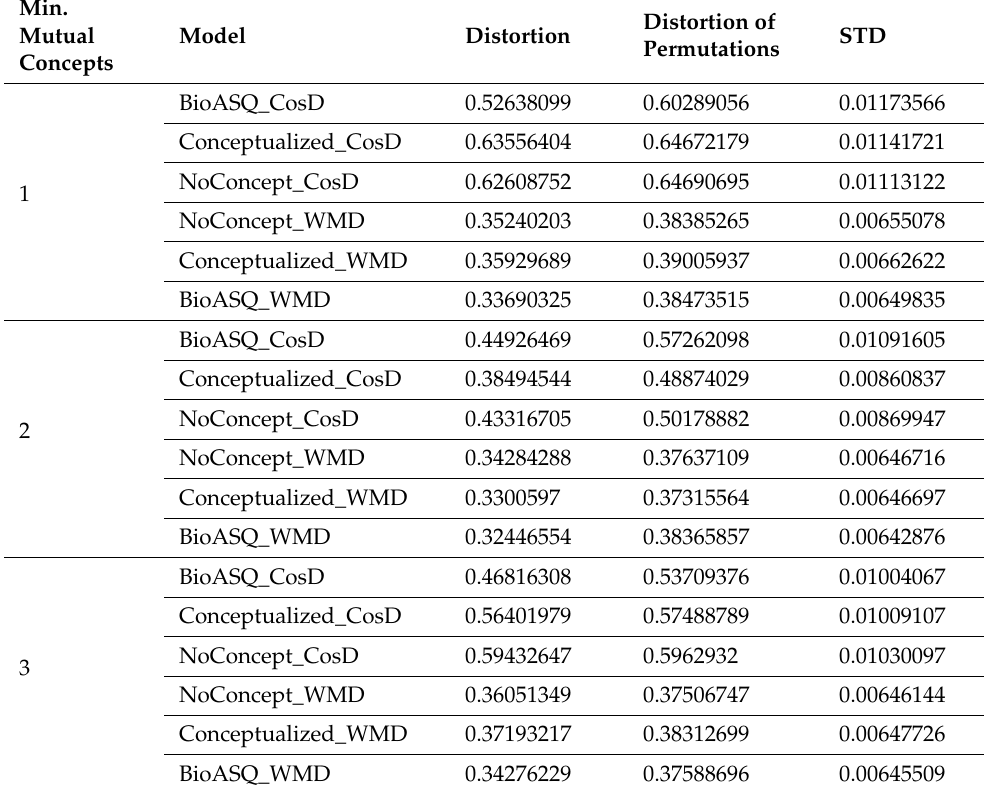
Table A2. Using the whole summary recommendations and minimum mutual concepts . This table shows the values obtained in additional experiments, where the whole CDC summary was used to obtain sets of mutual concepts (see above). Column 1 refers to the number of concepts overlapping with the summary. Distortion shows the distortions of graphs produced using corresponding models from Column 1. As before, in Tables 6 and A1 the distortion is somewhat depended on how we measure distances; however, the shapes of the distributions are very